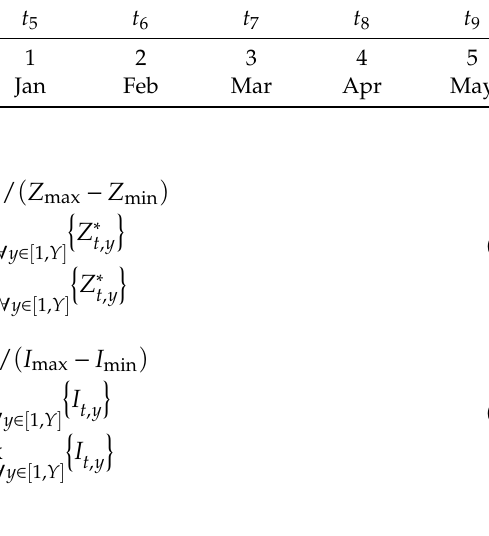
} and { I t } under the condition of a certain inflow. Z } and { I } under the condition of a certain inflow. t t t